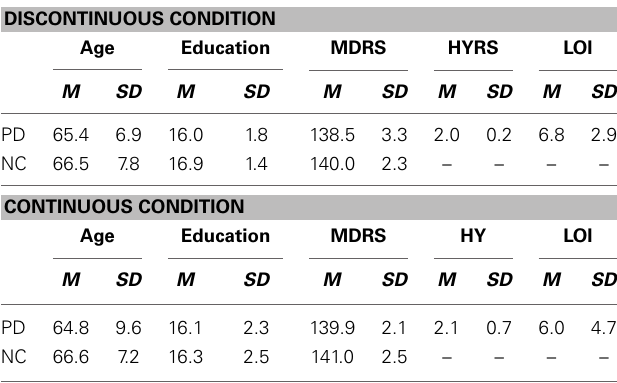
Table 3 | Demographic characteristics and Mattis Dementia Rating Scale Scores of the PD patients and NC participants in the Discontinuous and Continuous Conditions in Experiment 2.